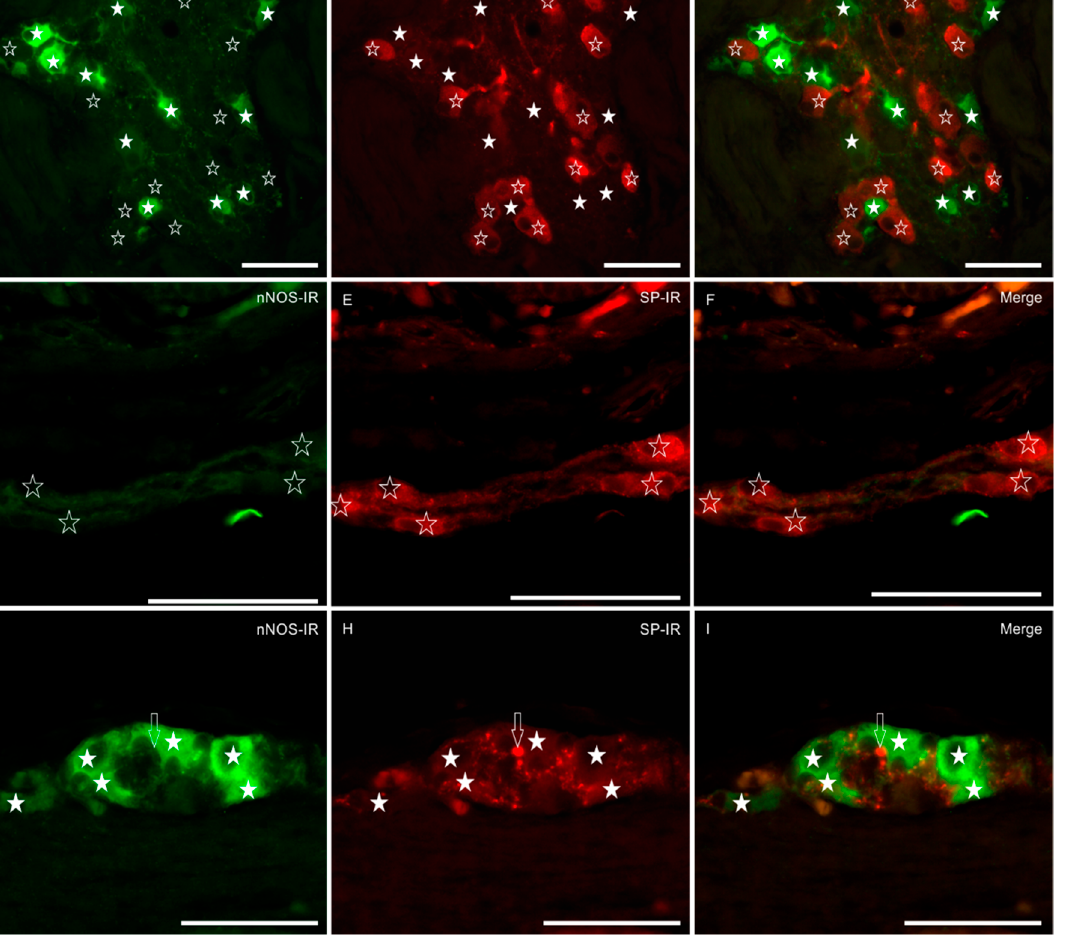
Figure 2. Micrographs of the sections of the myenteric plexus (MP) ( A – C ) and submucosal plexus (SMP) ( D – I ) of the bottlenose dolphin intestine. White stars indicate neurons showing neuronal nitric oxide synthase (nNOS) immunoreactivity (nNOS-IR); open stars indicate neurons showing substance P-IR (SP-IR). ( A – C ) Sections in which it is evident that no MP neurons co-expressed the two neuronal markers. ( D – I ) The SMP of the dolphin intestine was double layered; in the inner SMP ( D – F ), neurons preferentially expressed SP-IR ( E ) and were nNOS negative ( D ); nitrergic neurons were only observable in the outer SMP ( G – I ). The arrows indicate SP-IR varicosities encircling nitrergic neurons. ( C , F , I ) Merged images. Scale bar: 50 µm.